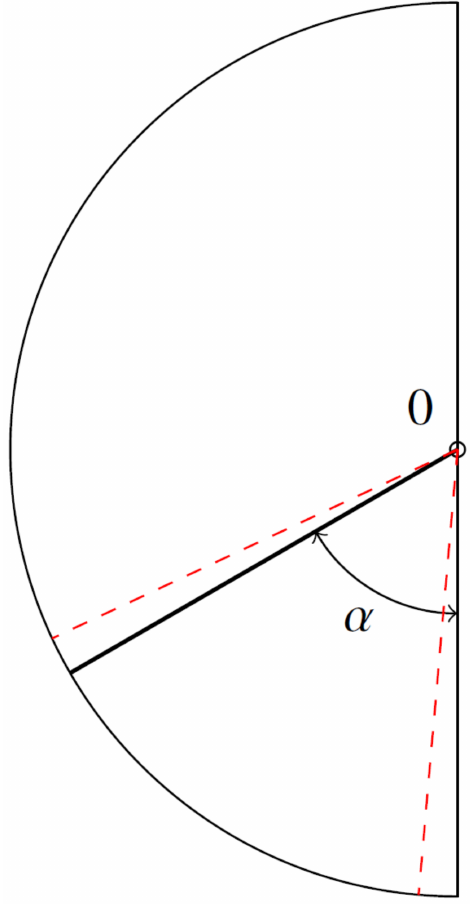
Figure 13. Illustration of the DC(60) distortion coefficient calculation procedure; U = 60 ◦ . Initially, the area, pressure, and angular position for each element at the outlet face are calculated. The area-averaged pressure is calculated for a 60 ◦ sector. Then the 60 ◦ sector is rotated by 5 ◦ increments. Then 60 ◦ sector with the worst average pressure is used for P t , 60 ◦ , min to calculate